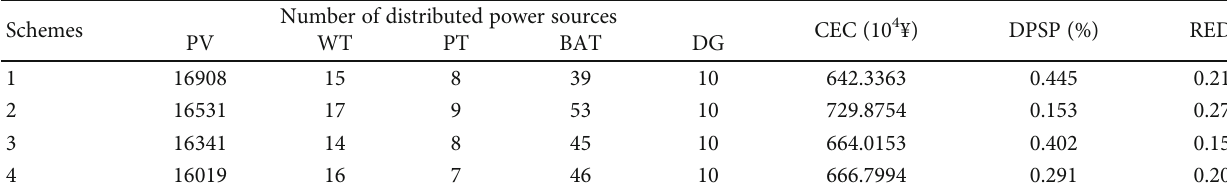
Table 5: Distributed power supply con fi guration results of